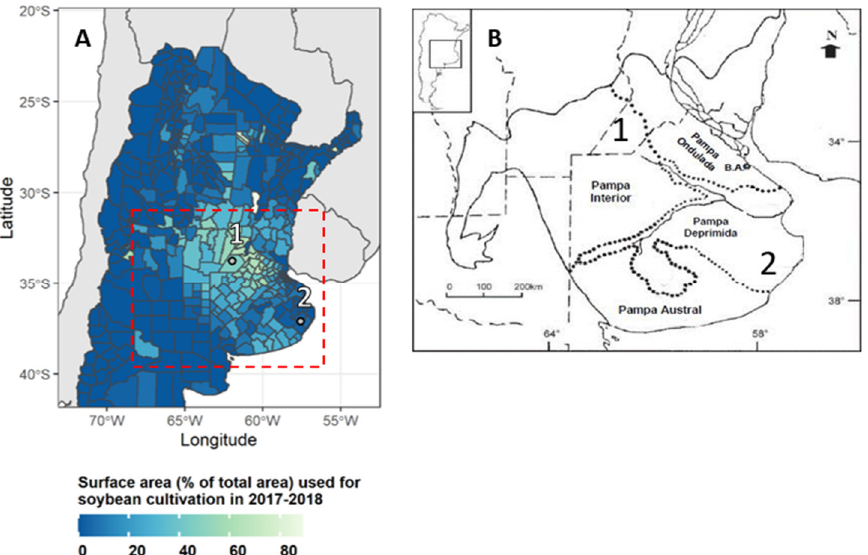
Figure 1. Intensity of soybean cultivation at the department level as a share of the total department area in Argentina ( A ) and sub-regions of the Pampas ( B ). Case study locations are shown in both figures as 1 (Departamento General L ó pez) and 2 (Partido General Juan de Madariaga). The red box in sub-figure A illustrates the area shown in map B. The sub-region map is adapted from Vilardo [34], with the original from Le ó n et al. [35]. The soybean intensity map is made by the authors based on the agricultural estimation dataset of the Argentinian Ministry of Agriculture